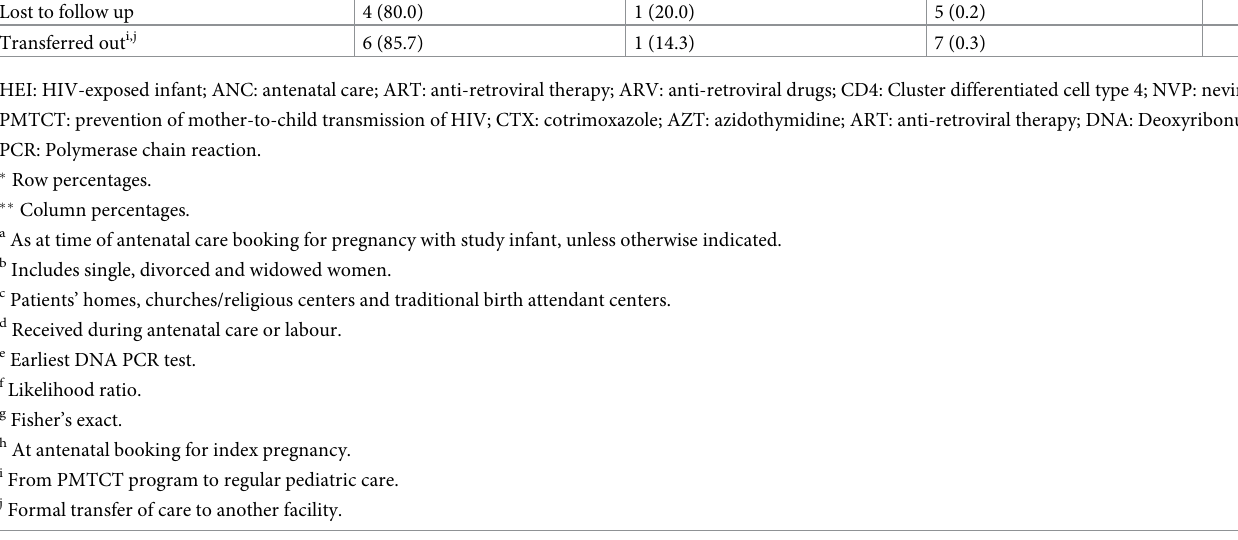
interventions (OR 4.57, p = 0.021) and infant birthweight < 2.5kg (OR 0.48, p = 0.022) were associated with higher odds of HIV-positive final outcomes for HEI (Table 3). The full model containing all predictors was statistically significant χ 2 (12) = 105.52, p < 0.001, indicating ability to differentiate HEI with positive or negative outcomes at � 18 months. The model explained 17% (Pseudo R 2 = 0.1721) of the variability in HEI outcomes and correctly classified 76.5% of the cases. HEI with birthweight of � 2.5 kg had 60% (aOR 0.40, p = 0.009) reduced risk of being HIV-positive compared to those with low birthweight of < 2.5 kg. Pregnant women living with HIV in urban areas had a 55% (aOR 0.45, p = 0.008) decreased likelihood of having an infant with final HIV positive status compared to those liv- ing in rural areas. HEI who were reported as exclusively breastfed for six months had a 96% reduced likelihood of vertical transmission (aOR 0.04, p < 0.001) compared to those